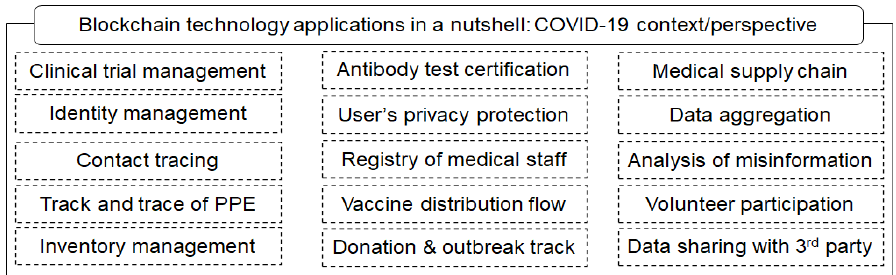
Figure 9. Key application of the BC technology in the context of